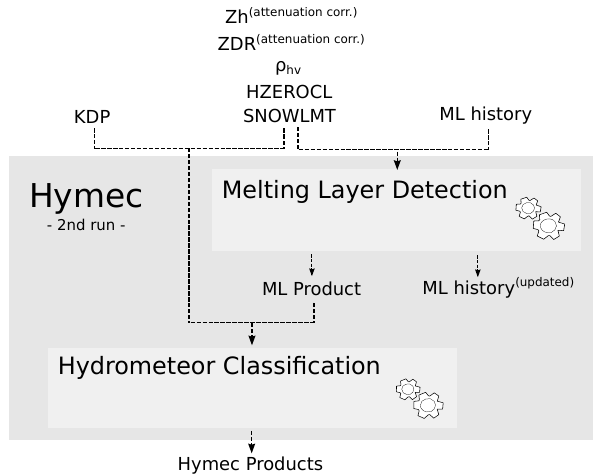
Figure 3. The inner structure of the second run of the Hymec al- gorithm (see Fig. 2) which includes the melting layer detection and update, and the hydrometeor classification. The Hymec processing is done for every PPI sweep and for each radar station